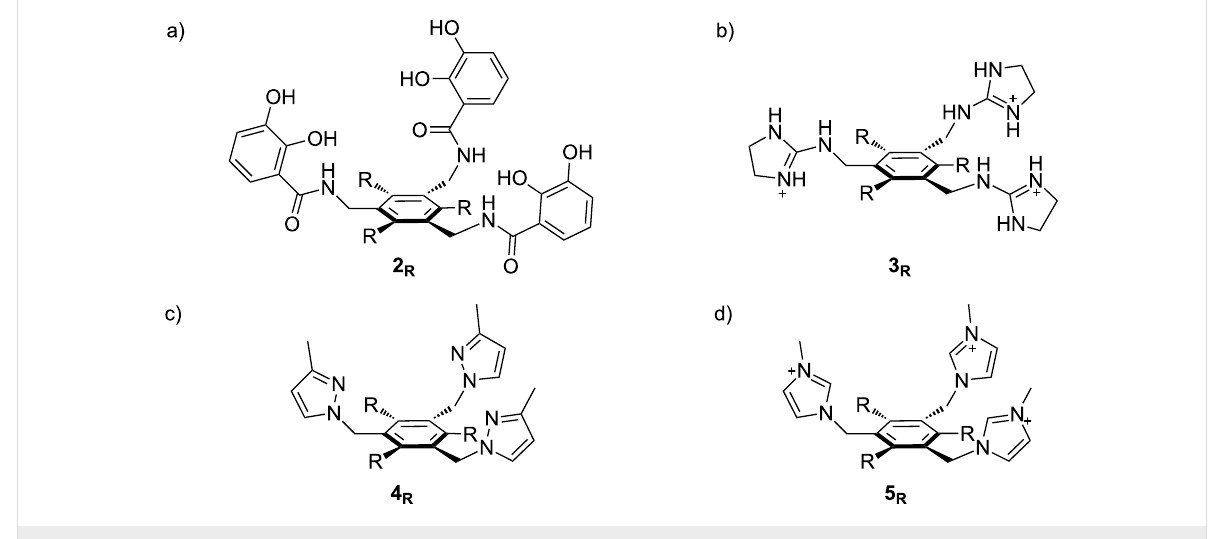
Figure 2: Structures of hosts discussed in this manuscript. R = H, Me, or Et.